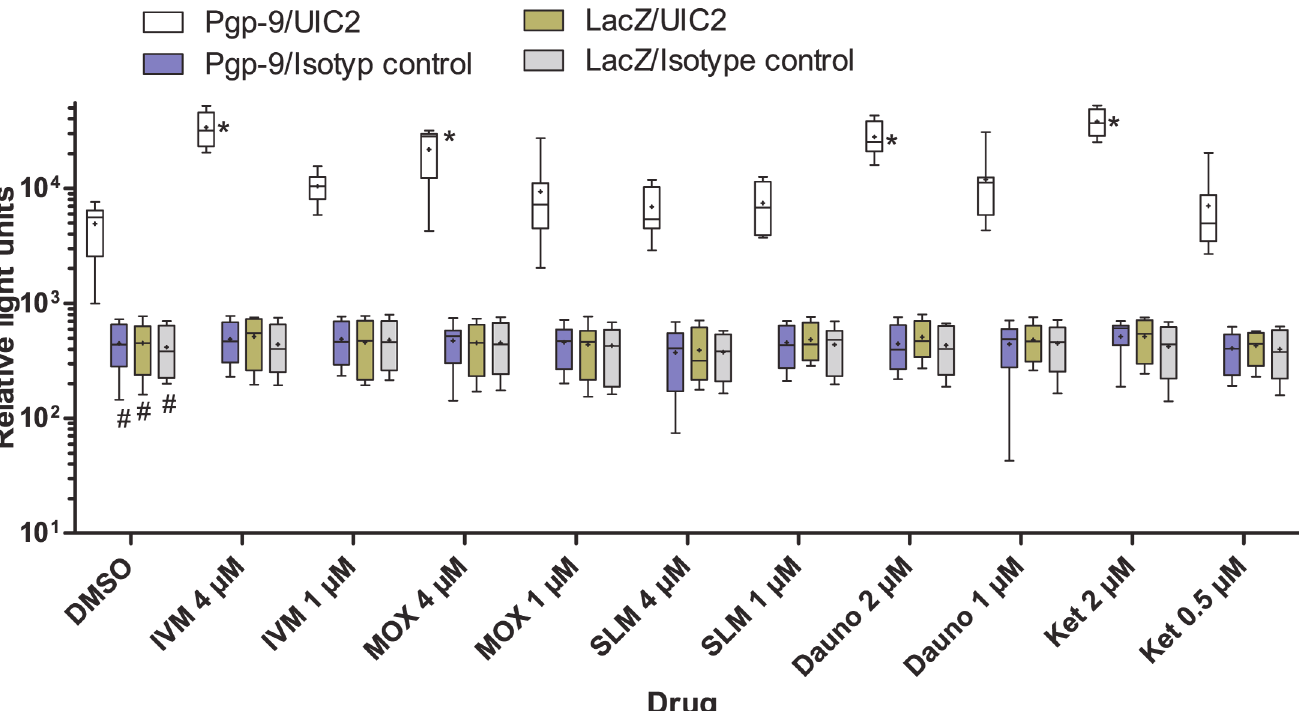
Fig 5. Changes in binding of UIC2 to Pgp-9 in response to the presence of drugs. AD1-7 Ceg Pgp-9V5His or control AD1-7 lacZ yeast cells were incubated with the indicated drugs in the presence of 1% DMSO or with DMSO alone. As an isotype control, the monoclonal antibody Mg2a-53 was used. Binding of antibodies was detected using a horseradish-peroxidase labeled secondary antibody and a luminol-based chemiluminescence reaction. Results represent 7 – 8 individual values recorded in 4 independent experiments with two technical replicates. Three replicates were excluded since apparently no luminol solution had been added to the wells. Whiskers represent the range of relative light units. The group means are indicated by +. Significant differences were detected using a Kruskal-Wallis test followed by a Bonferroni post hoc test against AD1-7 Ceg Pgp-9V5His with UIC2. One test was conducted comparing the samples exposed only to DMSO (first group) representing different combinations of yeast strain and primary antibody (#, p < 0.05). A second test compared the effects of different drugs on binding of UIC2 to AD1-7Pgp-9 (black symbols) ( * , p < 0.05).